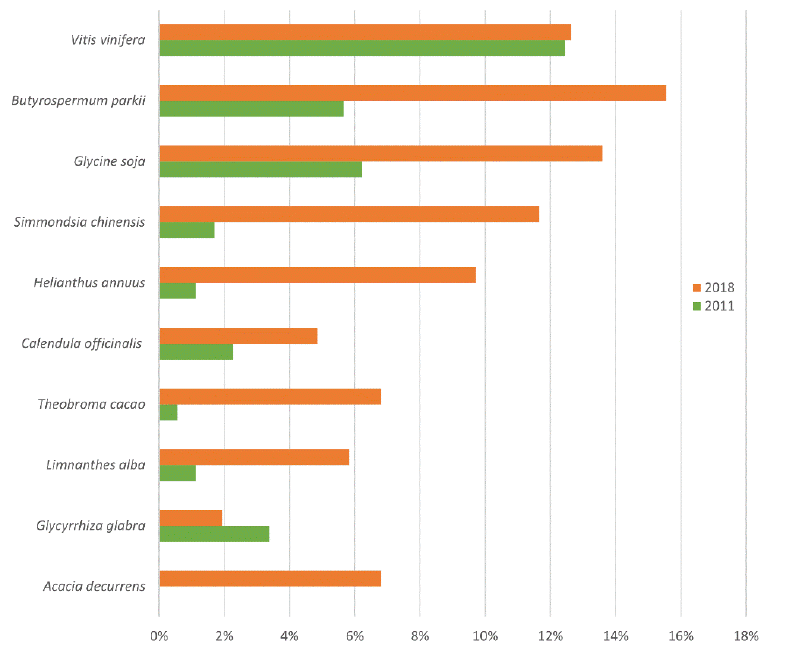
Figure 1. Top botanical species included in the composition of anti-aging products marketed in 2011 and 2018.